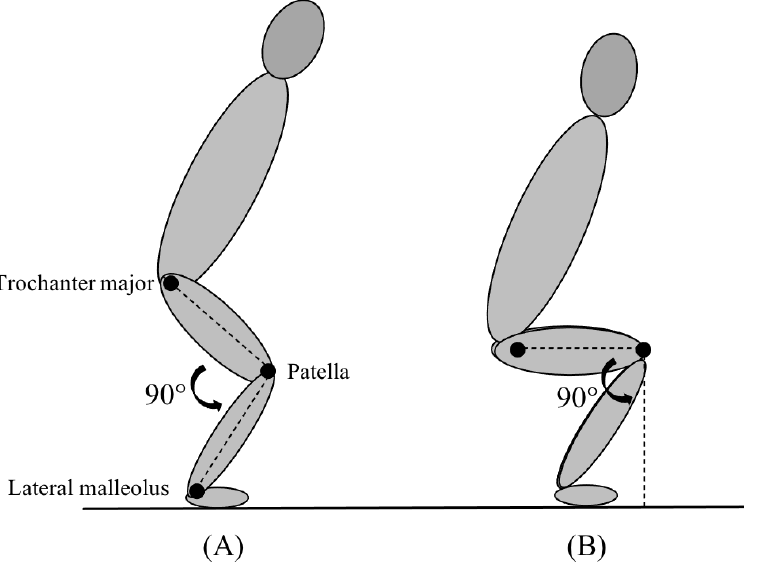
Figure 2. Depth requirements for the quarter squat and lateral squat ( A ) and the bilateral back squat ( B ).